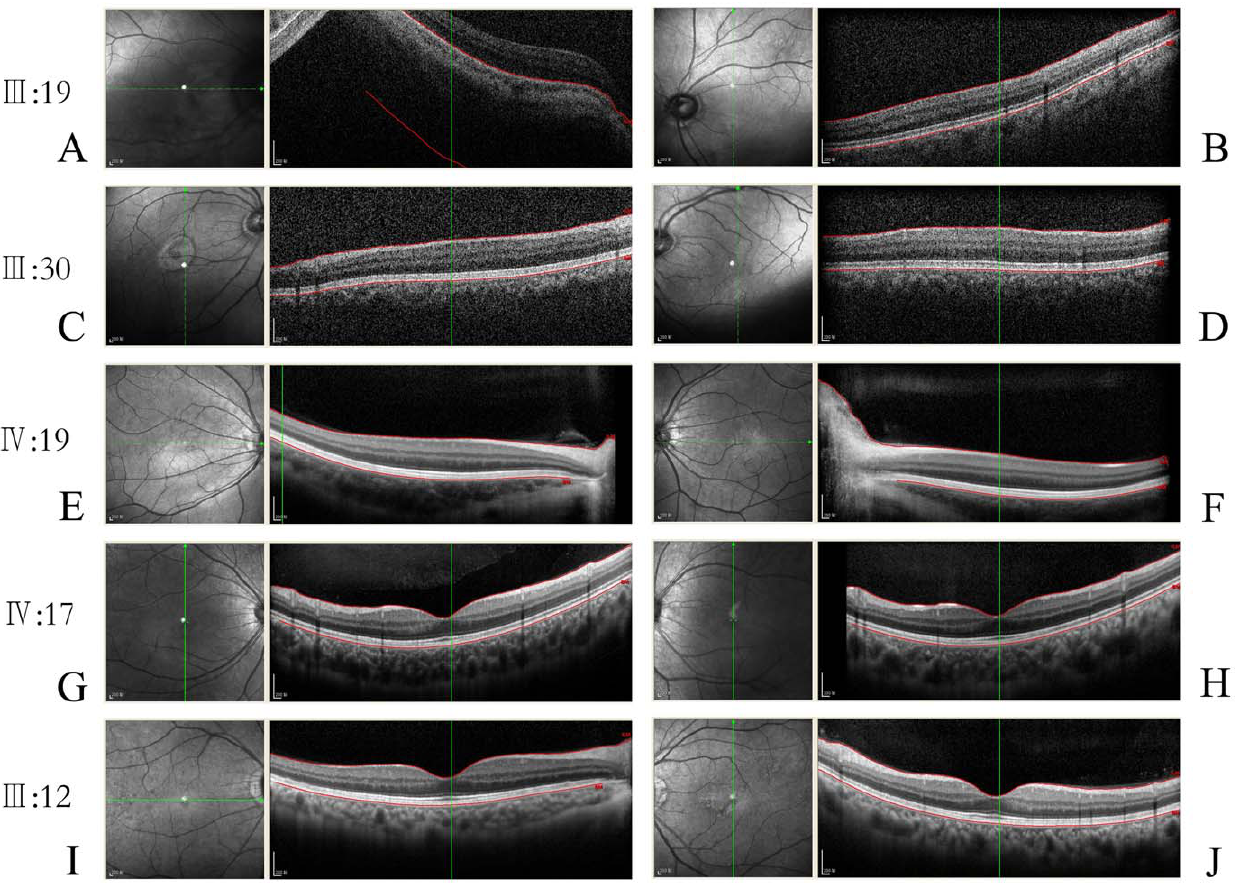
Figure 3. OCT test photographs of three patients, one carrier and one normal individual. A–F: three patients; G–H: one carrier; I–J: one normal individual. It should be noted that detailed structural imaging of the fovea was not successfully obtained in two patients (III:19 and III:30) with more severe nystagmus due to their poor fixation. Foveal image of one patient (IV:19) with relatively mild nystagmus was obtained.